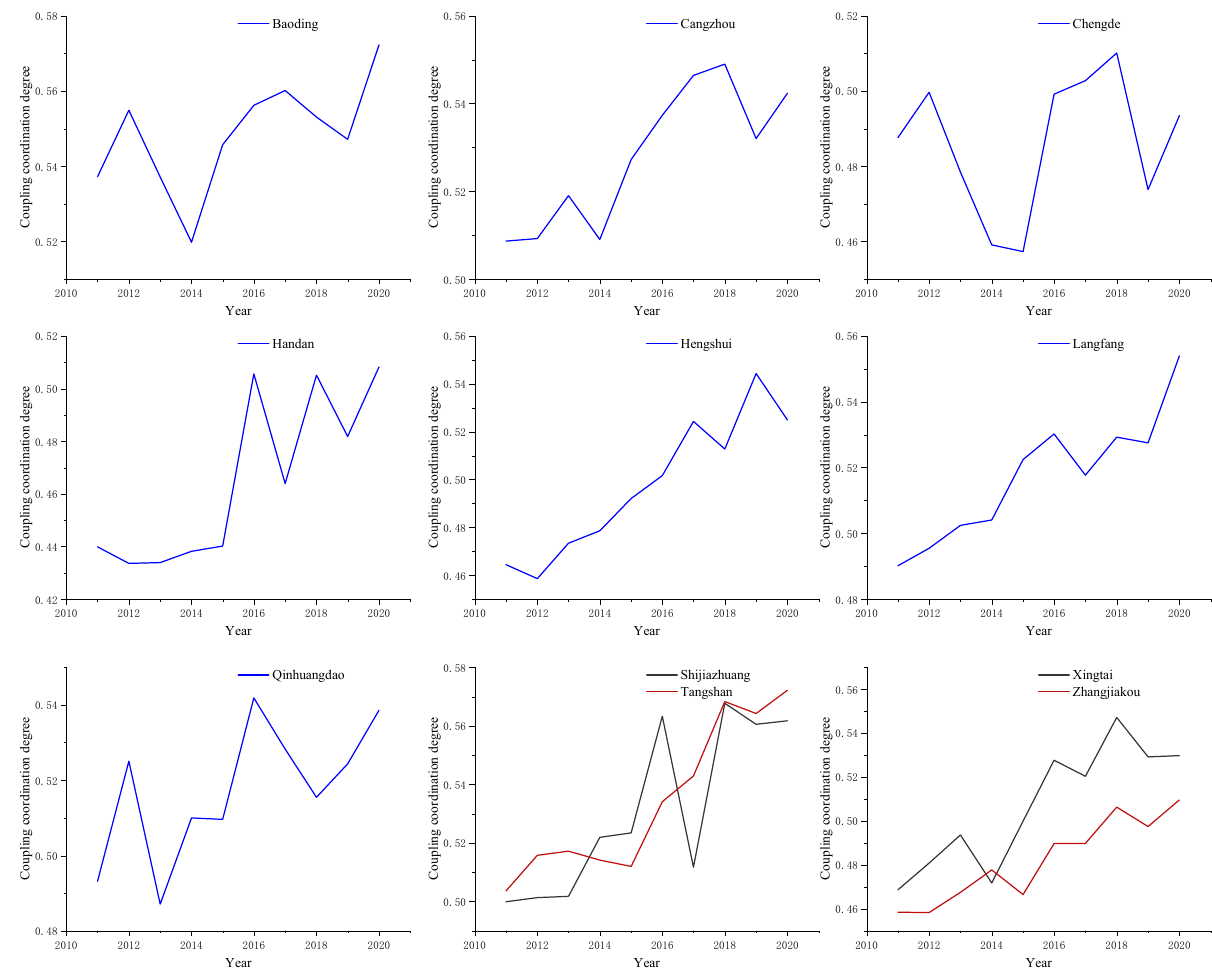
Figure 6. Coupling coordination degree values from 2011 to 2020.